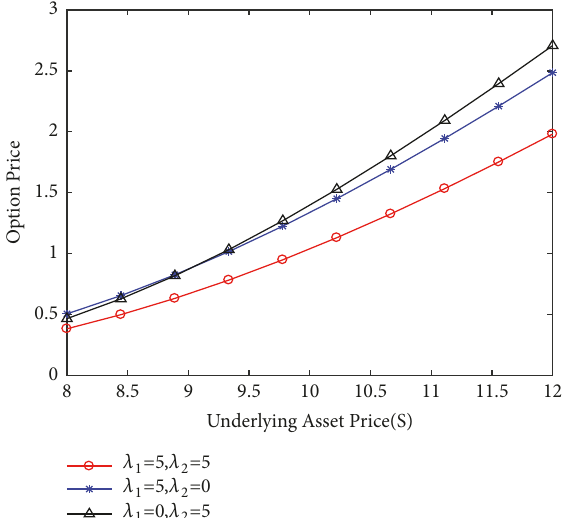
Figure 3: The influence of jump on vulnerable call option with incomplete information.